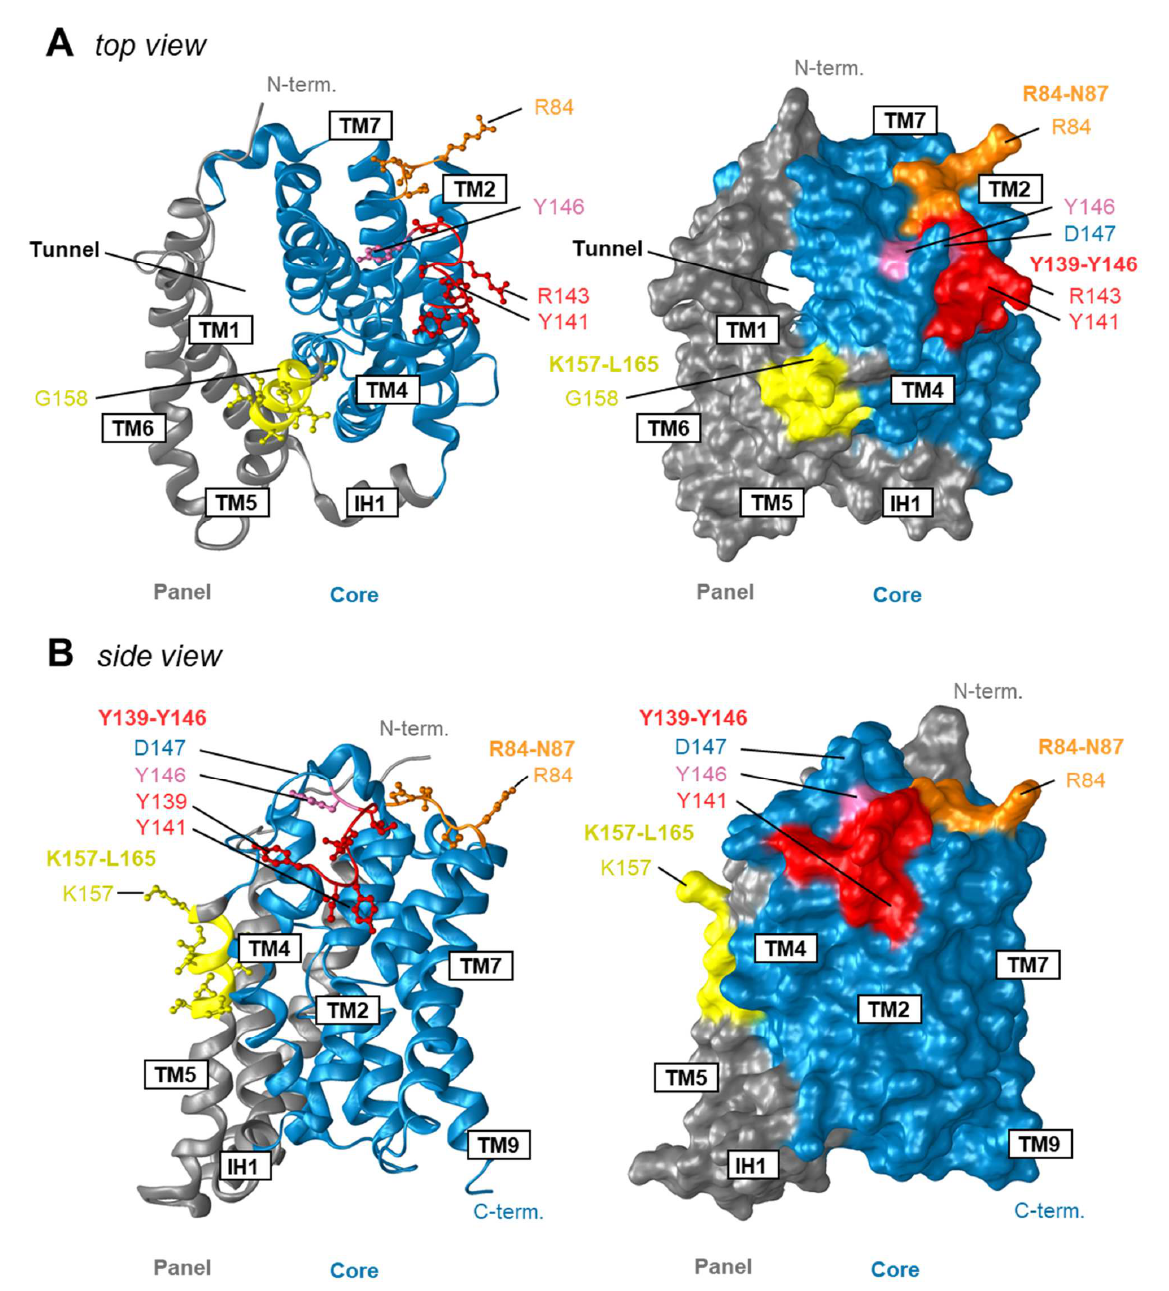
Figure 7. Regions at the human NTCP that are critical for viral myr-preS1 peptide binding. The structure is based on thermostabilized human NTCP in complex with Megabody 91 (PDB entry: 7PQQ; [14]) and demonstrates the localization of the Y141- and Y146-containing 139YIYSRGIY146 NTCP motif (red) in top view ( A ) and side view ( B ). Amino acid residue Y146 is labeled in pink. The model was visualized with the Protean 3D DNASTAR Software. Positions of amino acids of human NTCP involved in viral myr-preS1 peptide binding are labeled with colors: 157KGIVISLVL165 (yellow) and 84RLKN87 (orange).